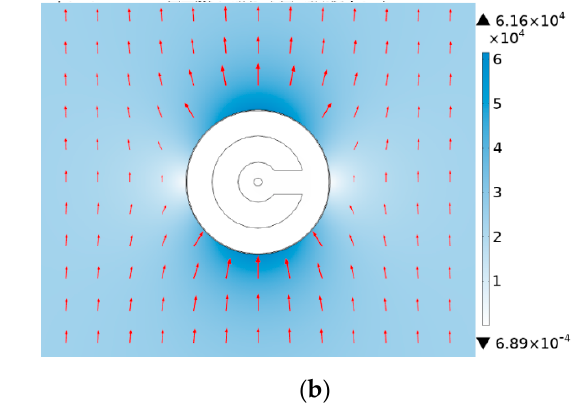
Figure 6. Shielding shell simulation: ( a ) simulation model, and ( b ) cloud map of the magnetic field distribution.